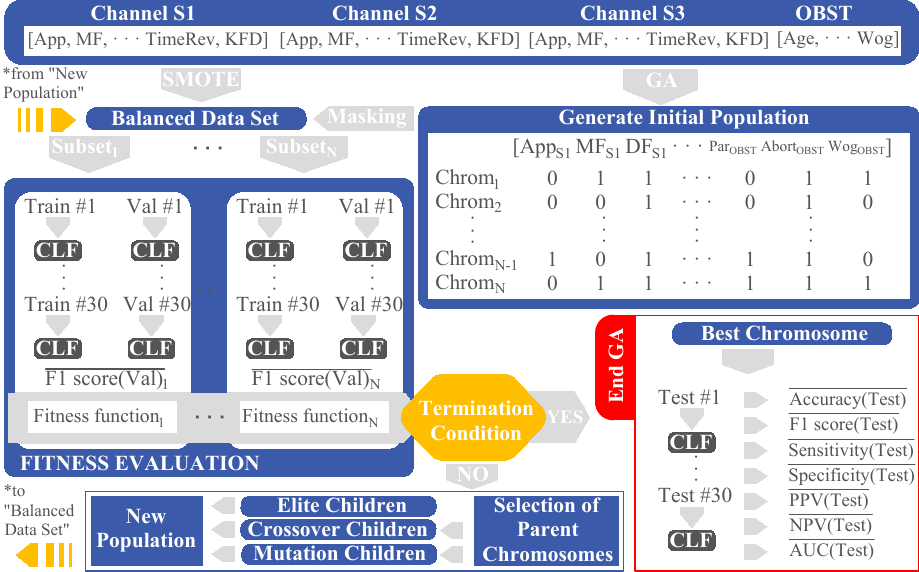
Figure 2. Genetic algorithm for selecting optimized feature subset to predict preterm labor based on EHG. Considering: genetic algorithm (GA), classifier (CLF), training partition (Train), valida- tion partition (Val), testing partition (Test), chromosome (Chrom), population size (N), obstetrics features